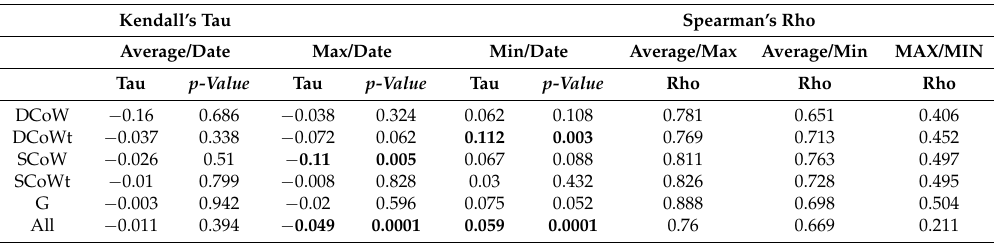
Figure 3. Intra-annual variability in EVI per land-cover types. Land-cover types: dense cork oak woodlands with understory (DCoW), dense cork oak woodlands without understory (DCoWt), sparse cork oak woodlands with understory (SCoW), sparse cork oak woodlands without understory (SCoWt), and grasslands (G). Box plots represent the mean (bold line within the box), variance (size of the box), and the range of values (whiskers). Open circles and asterisks represent outliers, out and far out respectively. Table 3. Trends in, and correlations between, average, maximum, and minimum EVI per land-cover type and total from 2000 to 2013. Bold values show significant trends. Land-cover types: dense cork oak woodlands with understory (DCoW), dense cork oak woodlands without understory (DCoWt), sparse cork oak woodlands with understory (SCoW), sparse cork oak woodlands without understory (SCoWt), and grasslands